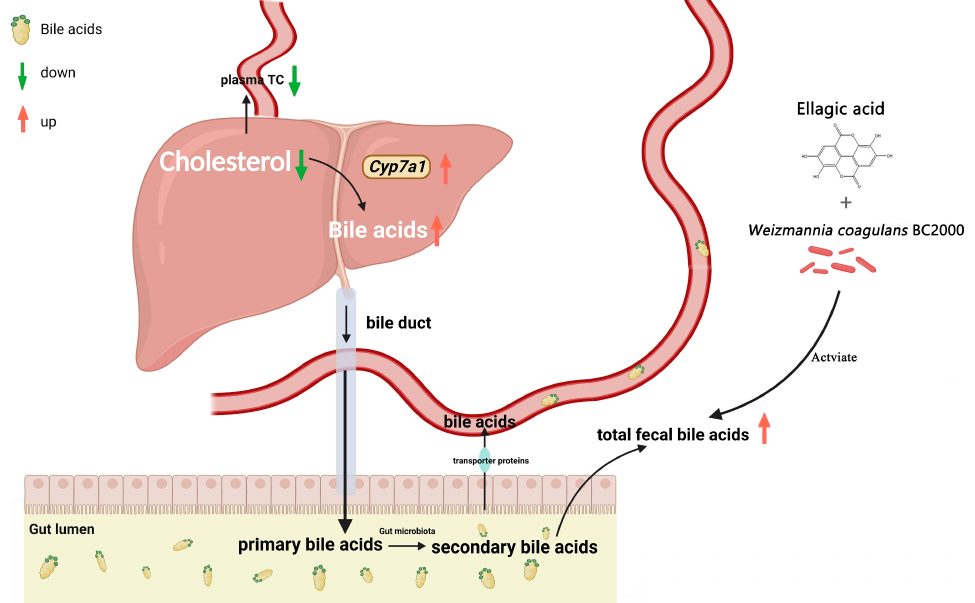
Figure 7. Proposed mechanism of the cholesterol-lowering effect of EABC2000 supplementation. LFD: low-fat-diet group; HFD: high-fat-diet group; EA: EA intervention group; EABC77: EA + Weizmannia coagulans BC77 intervention group; EABC2000: EA + Weizmannia coagulans BC2000 intervention group.